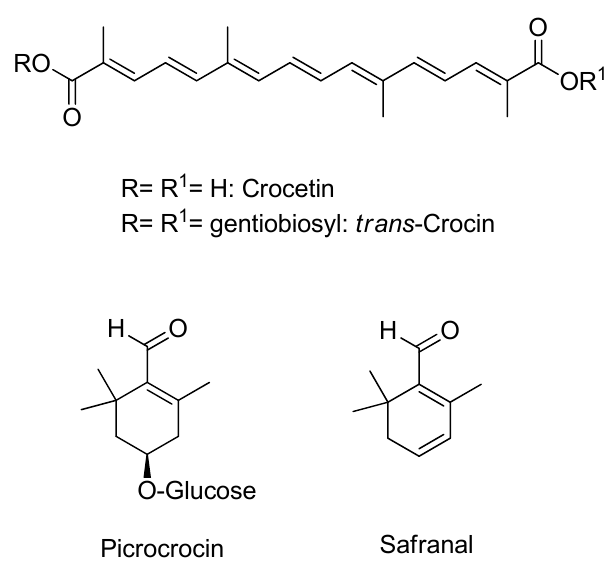
Figure 1. The chemical structure of the main bioactive compounds from the dried stigmas of Crocus sativus